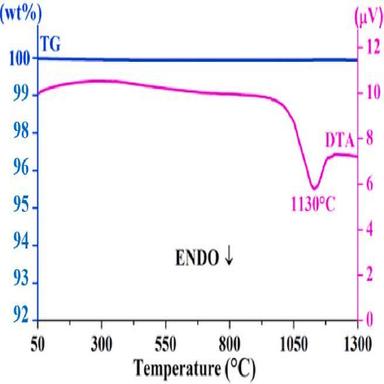
TG/DTA curves of starting materials mixture of Yb1.98Lu0.02Sn2O7.